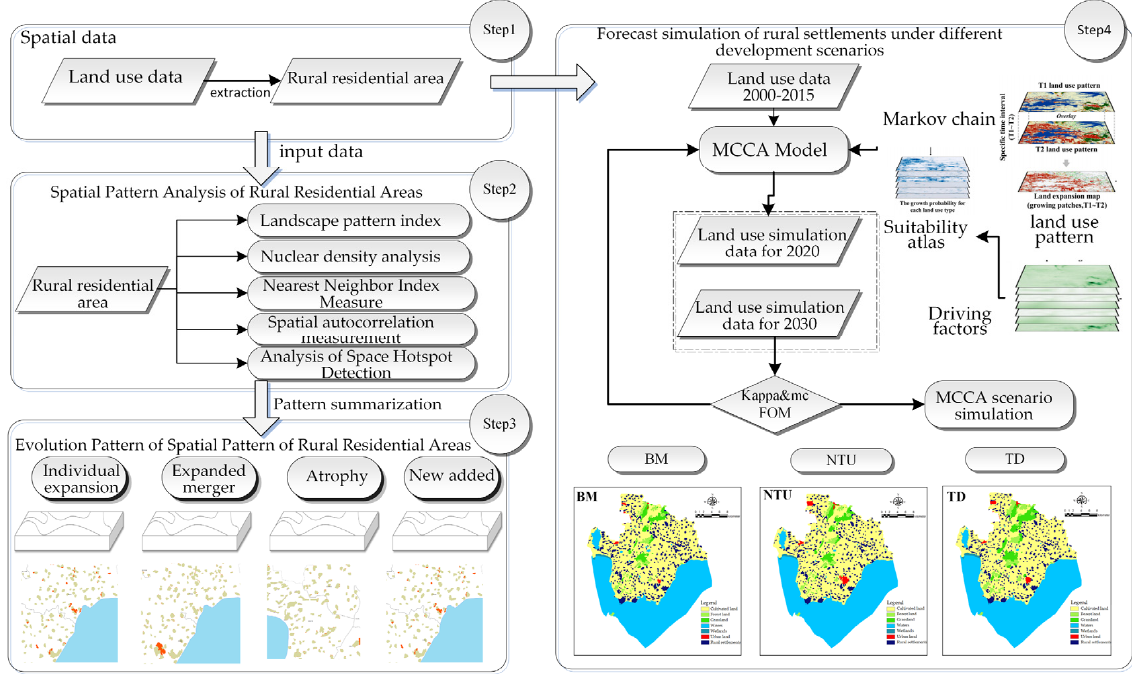
Figure 2. Research Technology Roadmap.